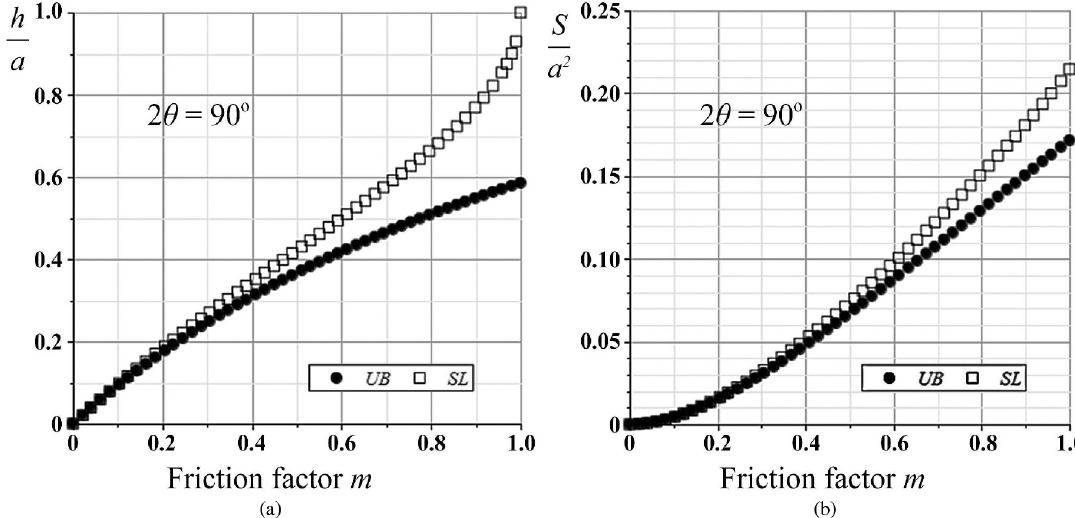
Figure 6. Relative height of a dead zone (a) and relative area of a dead zone (b) calculated from slip line (SL) and upper bound (UB)